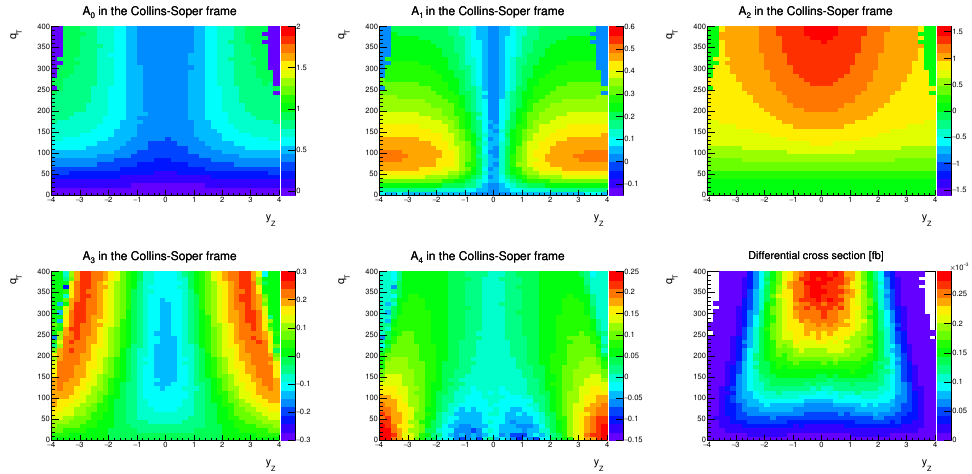
Figure 5 . Angular coe(cid:14)cients A 0 scenario S0 a .